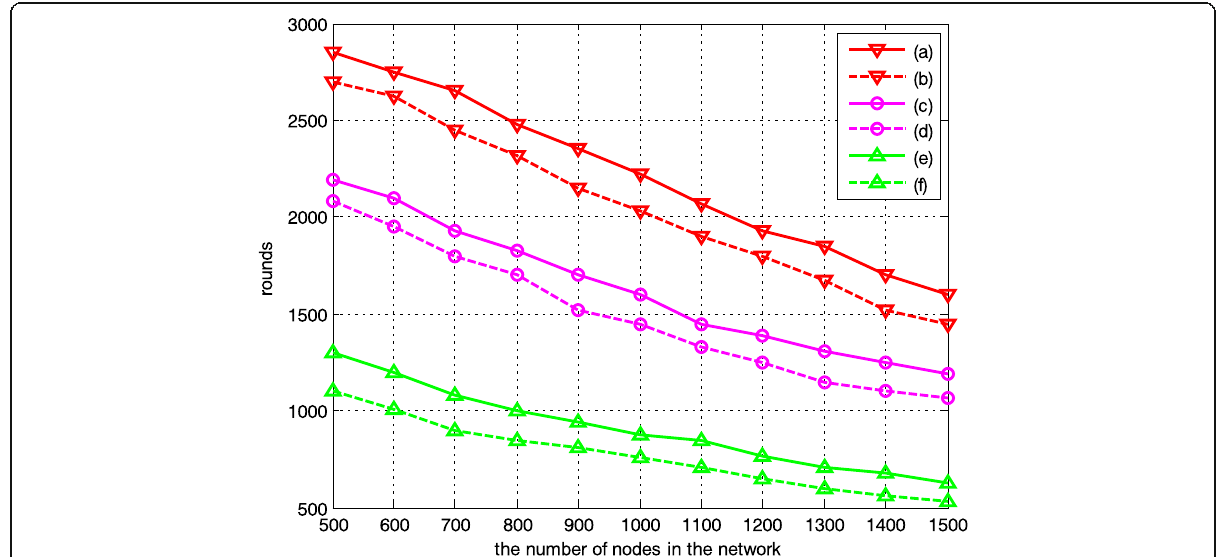
Fig. 6 Comparison of tendency of the network lifecycle changes with the number of nodes